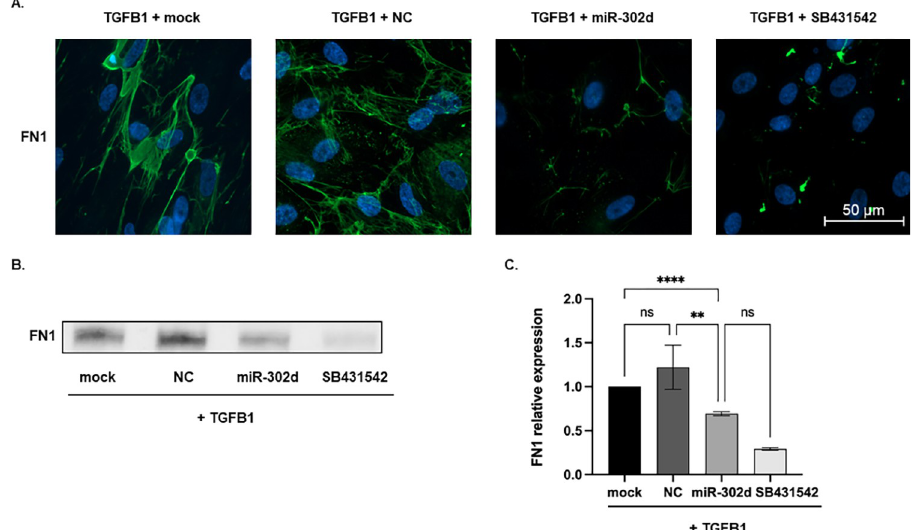
Fig 8. miR-302d inhibits the FN1 level in mesenchymal hRPE cells. (A) ICC staining and (B) representative Western blot of FN1 in hRPE cells after 4 d TGFB1 treatment and 3 d transfection. The scale bar represents 50 μ m. (C) The relative expression of FN1 normalized to total proteins (S1 Raw images). The values were further normalized to the "TGFB1 + mock" group. One-way ANOVA with Tukey’s multiple comparisons tests (n = 3) were performed. The error bars represent SD. ns, non-significant, �� p < 0.01, ���� p < 0.0001.